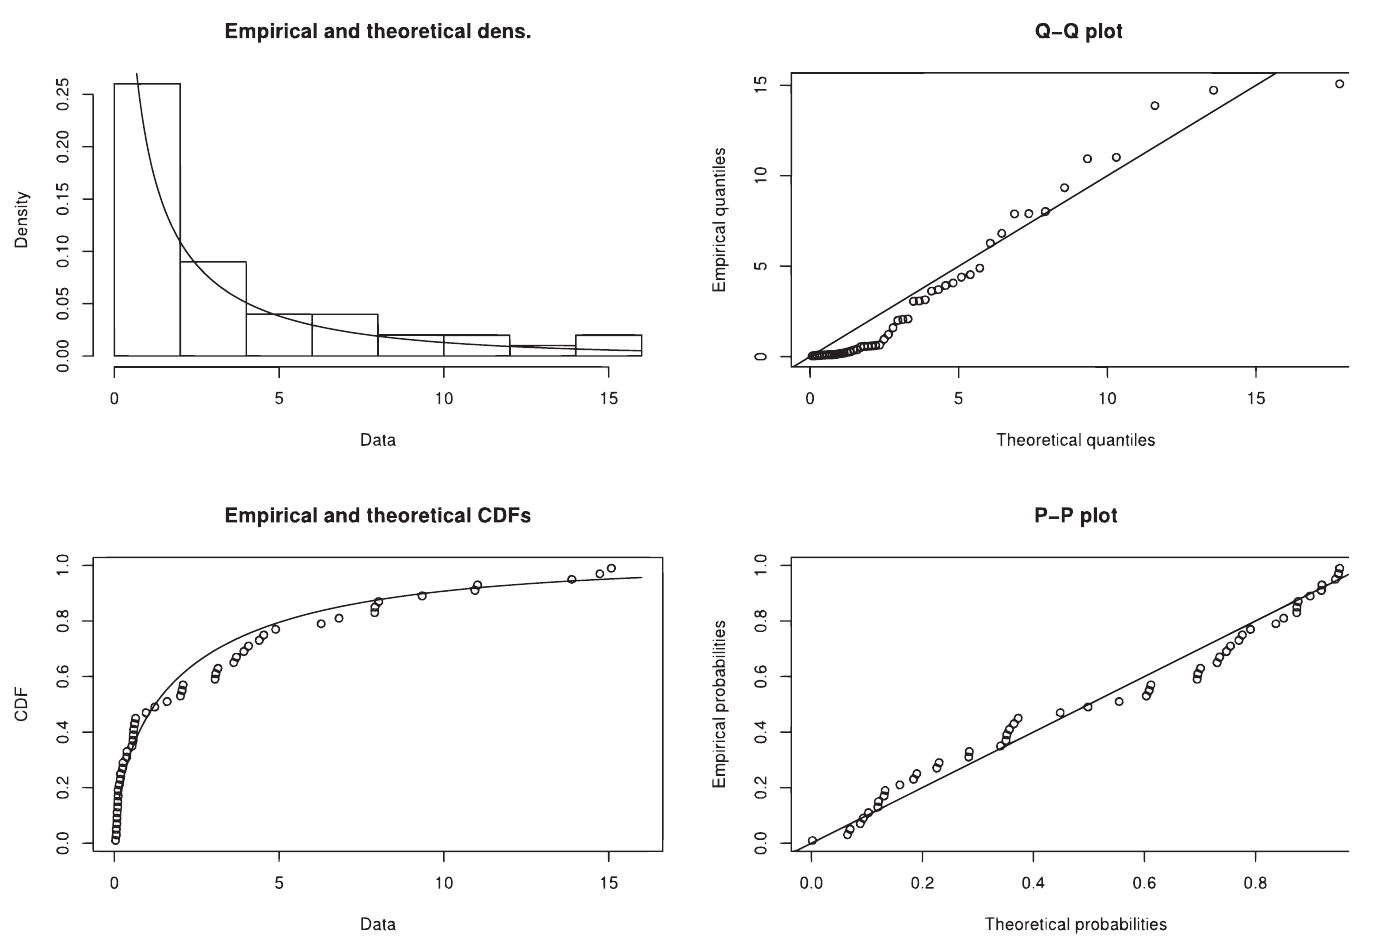
Fig 4. The fitted pdf of W-TEXPD on the histogram of failure times of 50 components (per 1000 hours) along with their cdf, Q-Q and probability plots.